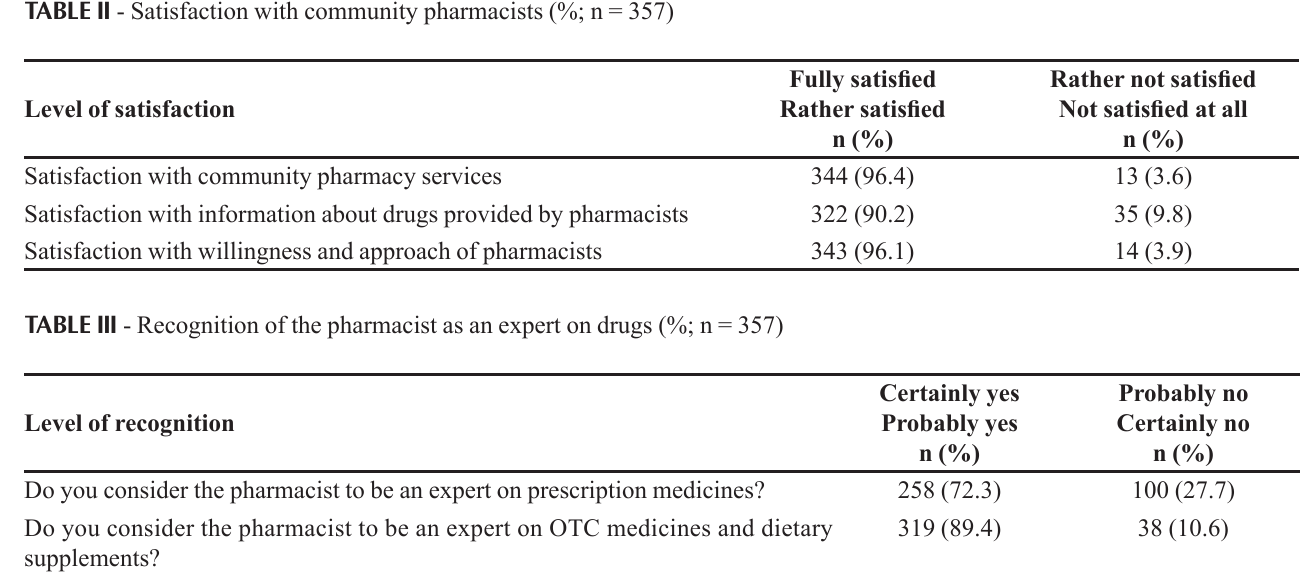
TABLE II - Satisfaction with community pharmacists (%; n = 357)